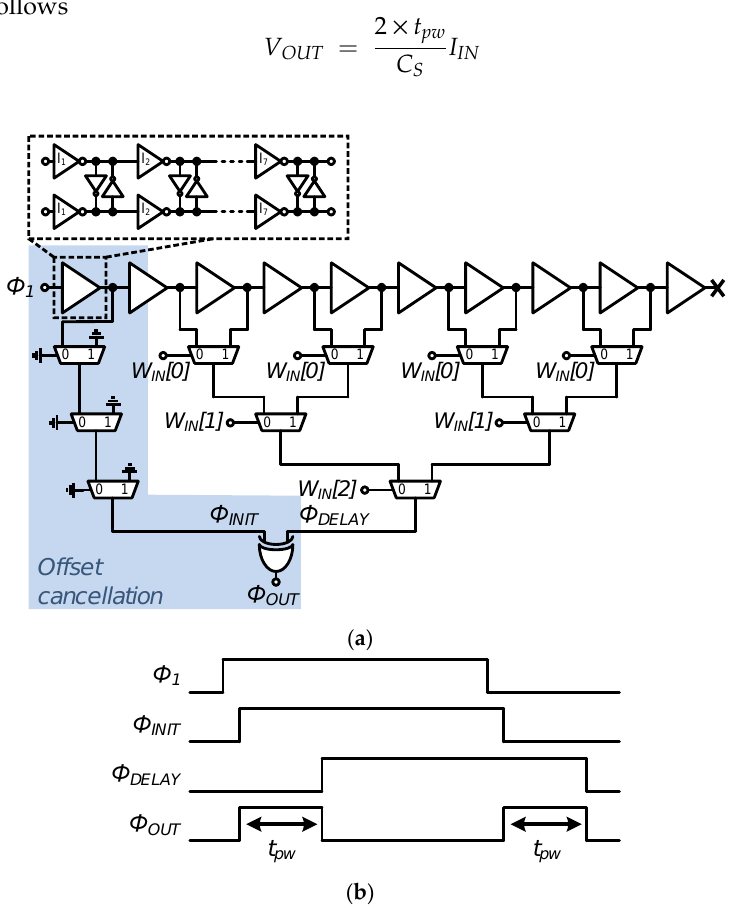
Figure 5. Proposed offset-free digital-intensive pulse-width modulator: ( a ) circuit diagram and ( b ) timing diagram.